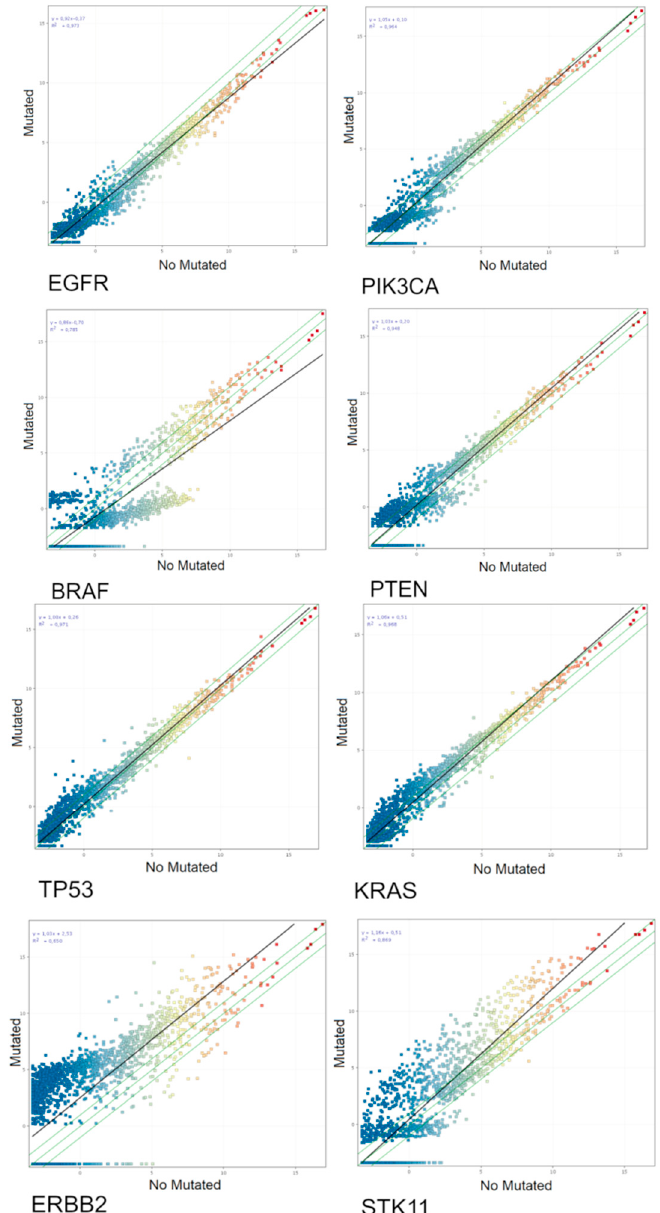
Figure 2. Scatter plot analyses of the miRNA-chip-array results from tumoral lung biopsies of analyzed patients without (horizontal axis) and with (vertical axis) mutations for the oncogenes TP53 , KRAS, EGFR, PIK3CA, ERBB2, STK11, BRAF, and PTEN . The miRNA profile was significantly related with the mutational status of the analyzed oncogenes as demonstrated by the miRNA changing their expression more than two-fold falling outside the two-fold variation interval indicated by the diagonal green lines. The slope of the best fit regression line (black diagonal line) indicates the overall trend toward up or downregulation for the mutational status of each